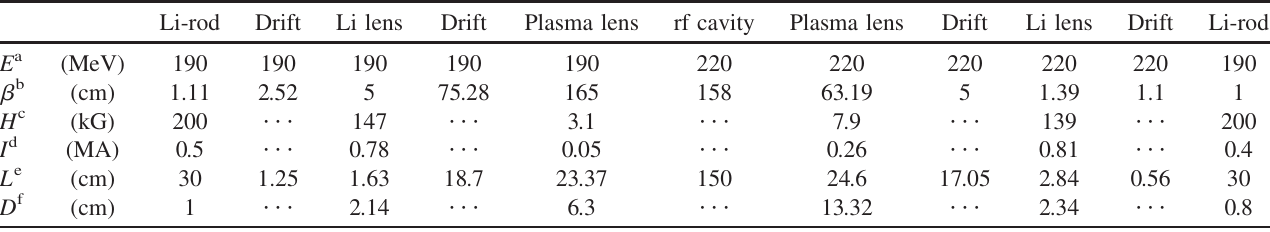
TABLE I. Example of element parameters for one period of the cooling channel.